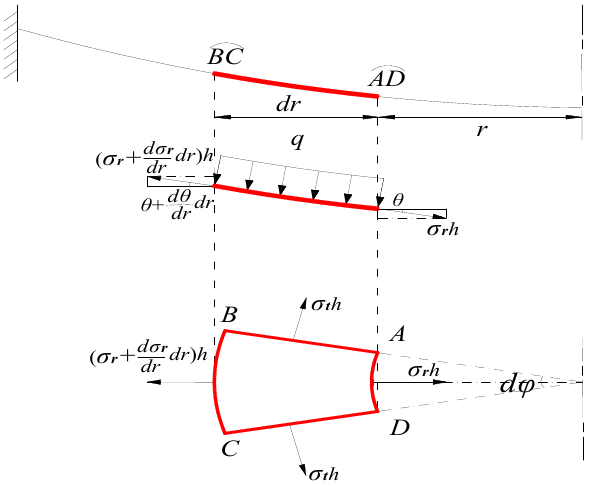
Figure 5. Sketch of the differential element body ABCD where the red curves denotes the Profile of the thin film.